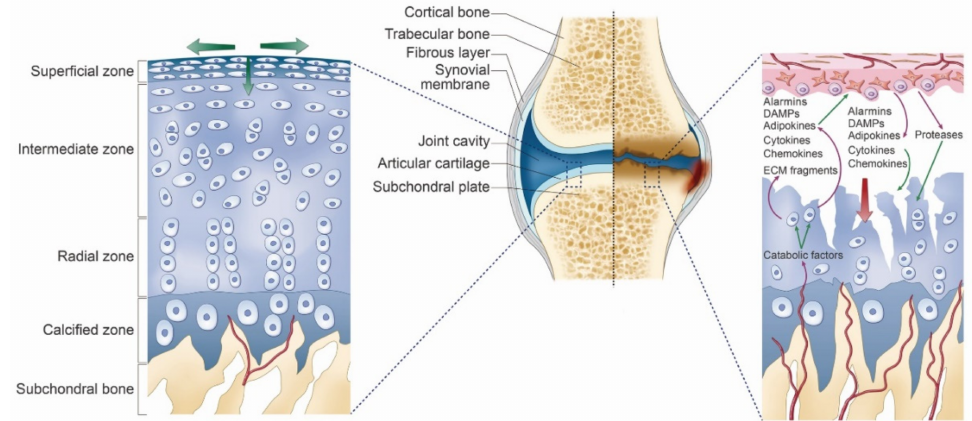
Figure 1. Mechanisms for the osteoarthritis of the knee. Healthy articular cartilage (Left)—Because of absence of vessels within cartilage, chondrocytes can live in a hypoxic environment. Hypoxia is important for chondrocyte function and survival. The main function of cartilage is the absorption and the removal of mechanical load, which is necessary to maintain cartilage homeostasis. Osteoarthritis articular cartilage (Right)—Development of vessels (called vascular channels) are supposed to facili- tate biochemical communication between the bone and the cartilage (such as cytokines, chemokines, alarmins). It initiates a vicious cycle of cartilage